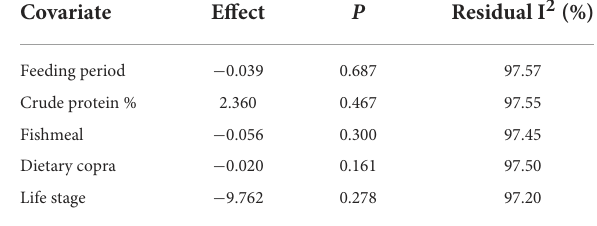
TABLE 2 Meta-regression for final weight.